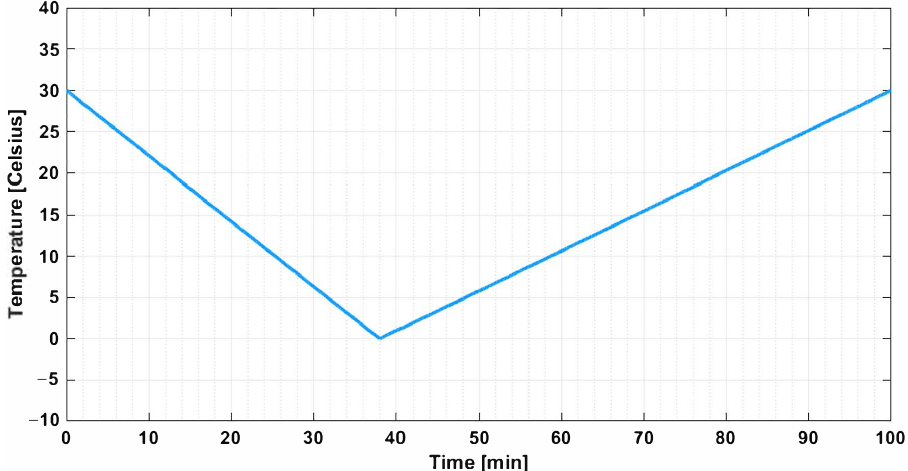
Figure 1. An ambient temperature model with one orbit period